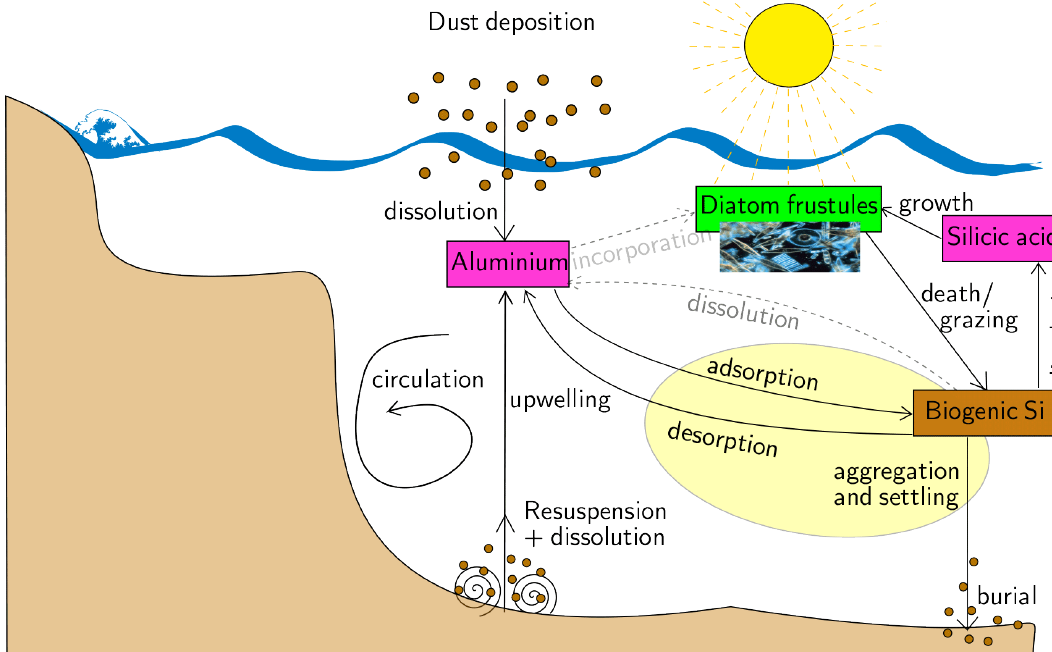
Figure 3. Aluminium cycling in the ocean. Dissolved Al enters the ocean through the release of Al diss from deposited dust and resuspended sediments, while rivers, hydrothermal vents and reducing sediments are negligible sources of Al diss . Al is mostly removed by reversible scavenging (presented in the yellow ellipse). The dashed arrow from aluminium to diatom frustules signifies incorporation of Al into diatom frustules. Silicic acid (Si diss ) is presented as well, since it is an essential part of understanding Al cycling. However, not all sources of Si diss are presented in this